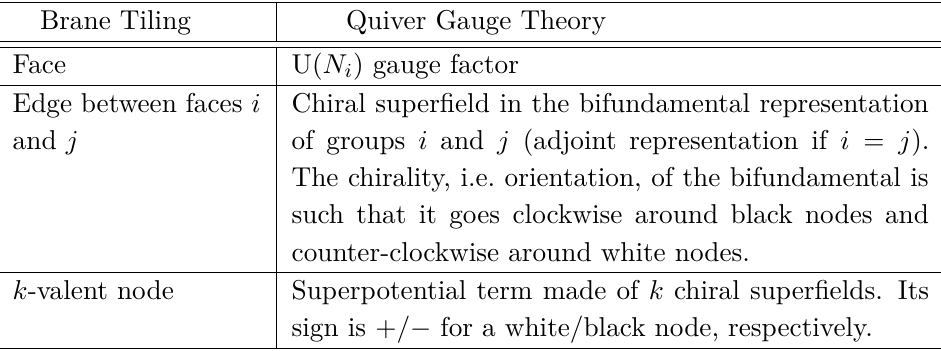
Table 1. Dictionary relating brane tilings to quiver gauge